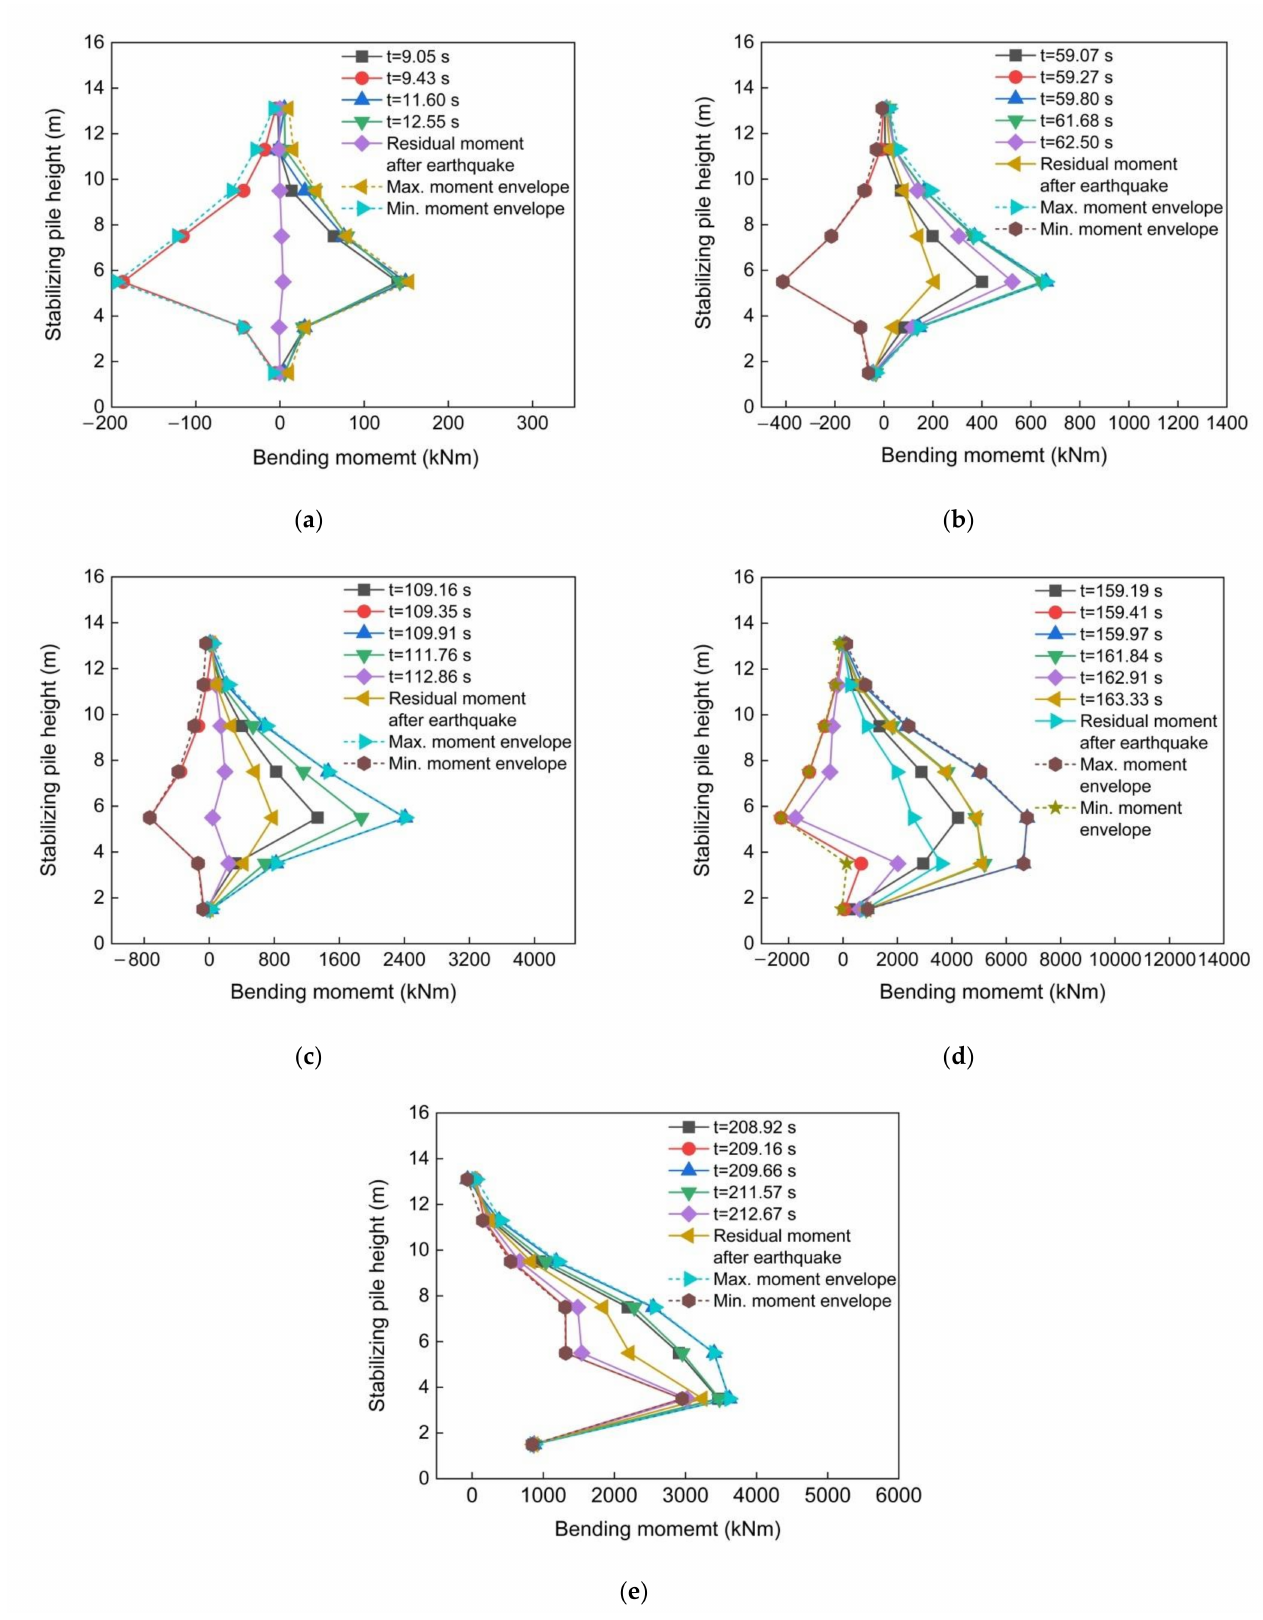
Figure 16. Maximum and minimum bending moment envelopes, residual bending moment after an earthquake, and the dynamic bending moment on a stabilizing pile: ( a ) EQ1; ( b ) EQ2; ( c ) EQ3; ( d ) EQ4; ( e )